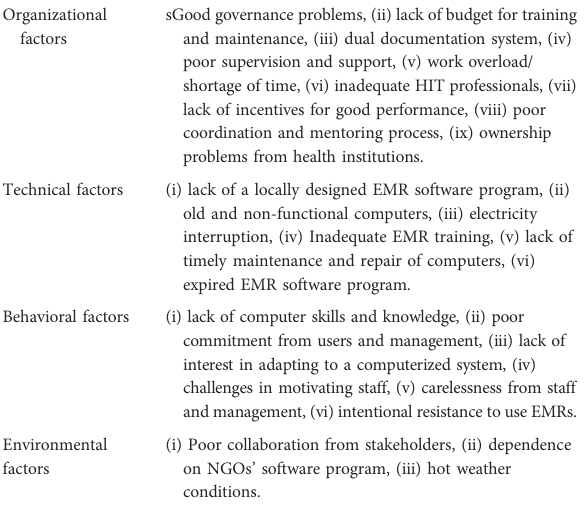
TABLE 4 Common themes identi fi ed during in-depth interviews on factors affecting health professionals ’ EMR use. Organizational sGood governance problems, (ii) lack of budget for training factors and maintenance, (iii) dual documentation system, (iv) poor supervision and support, (v) work overload/ shortage of time, (vi) inadequate HIT professionals,